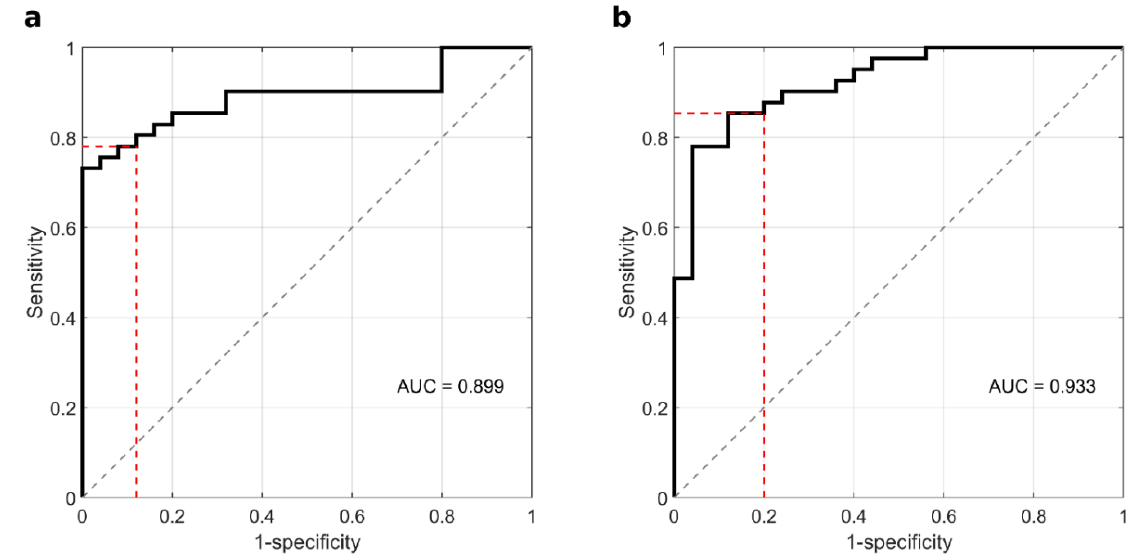
Figure 4. ROC curve obtained by LDA in the following 2-parameter spaces: ( a ) 20–30 kDa integral area and alpha 1 level, and ( b ) 20–30 kDa integral area and alpha 2 level.